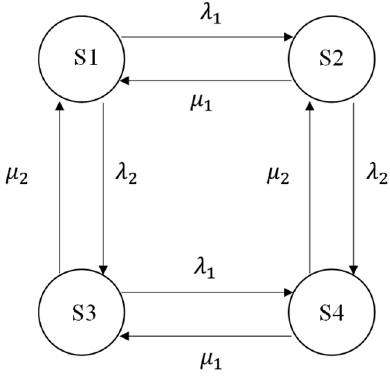
Figure 3. The Markov model of a system with two components. Table 3. The possible states of a system with two components.